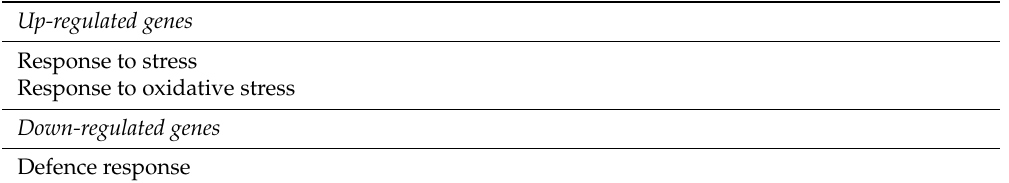
Table 3. Over-represented GO categories (biological function ontology) in the subset of differentially-expressed genes in C2-expressing plants in response to JA, as compared to control plants. Differentially Expressed Genes in C2 Plants in Response to JA (Compared to Control Plants)